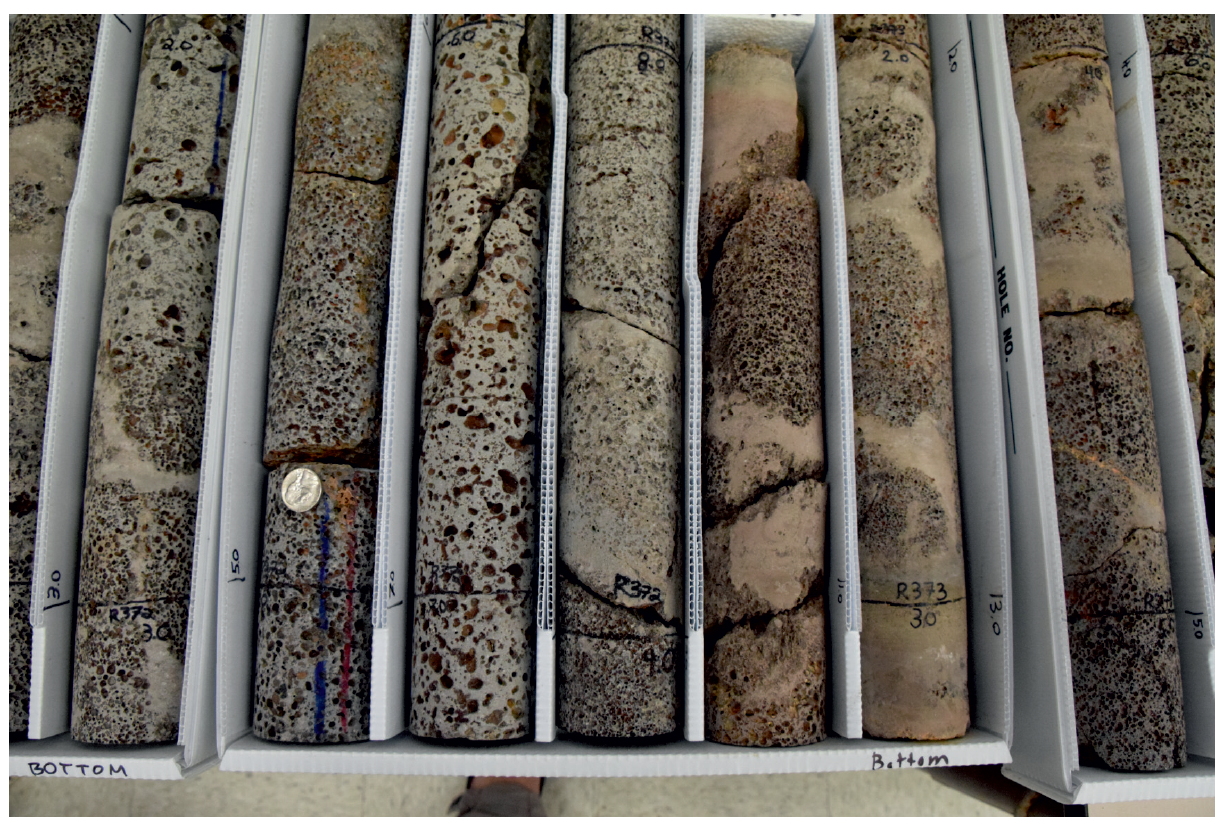
Figure 3. Example of the exceptional core recovery from the wells (further examples can be seen in Figs. 9 and